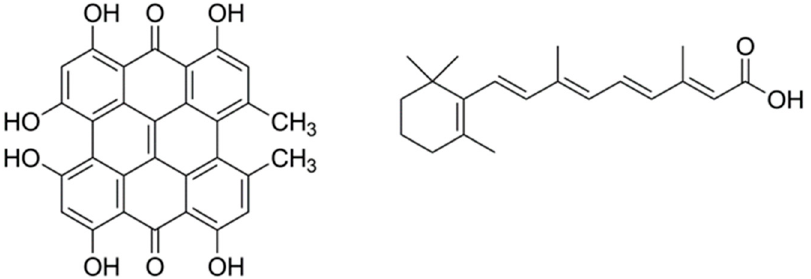
Figure 1. The molecular structures of hypericin ( left ) and all- trans retinoic acid ( right ).